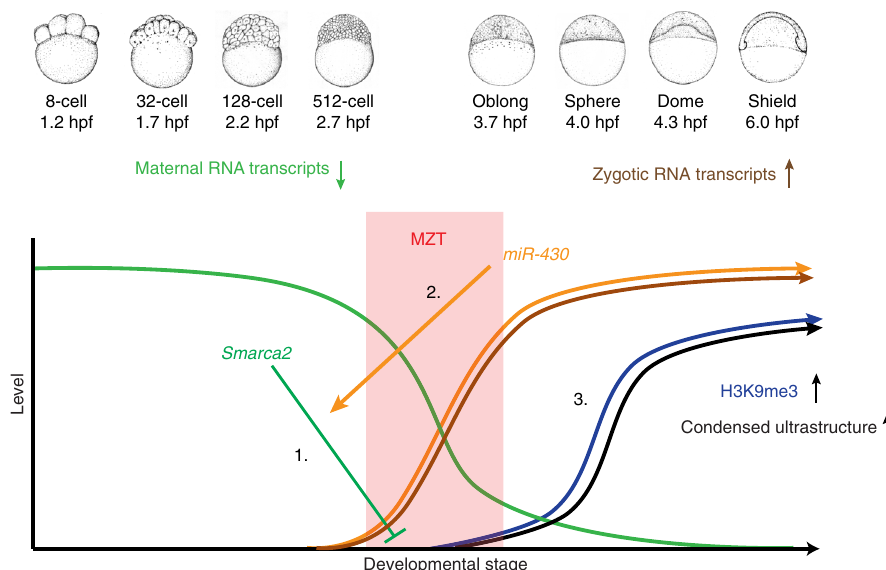
Fig. 7 Model for Smarca2-miR430-dependent heterochromatin formation. The early embryo relies exclusively on maternally deposited RNA transcripts and protein, and only starts transcribing the zygotic genome at the maternal to zygotic transition. This model shows that maternal smarca2 , a catalytic subunit of the BRG1/BRM-associated factor (BAF) complex, inhibits H3K9me3 incorporation and chromatin condensation prior to the maternal zygotic transition (1). At the onset of zygotic transcription, the microRNA miR-430 is transcribed and targets maternal smarca2 for degradation (2). Decreasing levels of smarca2 are suf fi cient to allow for the incorporation of H3K9me3 and formation of condensed chromatin ultrastructure post maternal to zygotic transition (MZT) (3). Zebra fi sh embryonic stage schematics are reproduced from Kimmel et al. 22 with permission from John Wiley & Sons